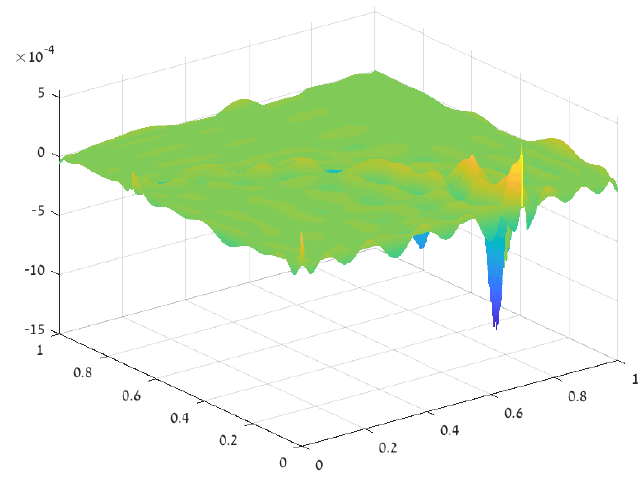
Figure 16. The approximation error with D ¯